Question: From the figure, is the trend upward or downward?
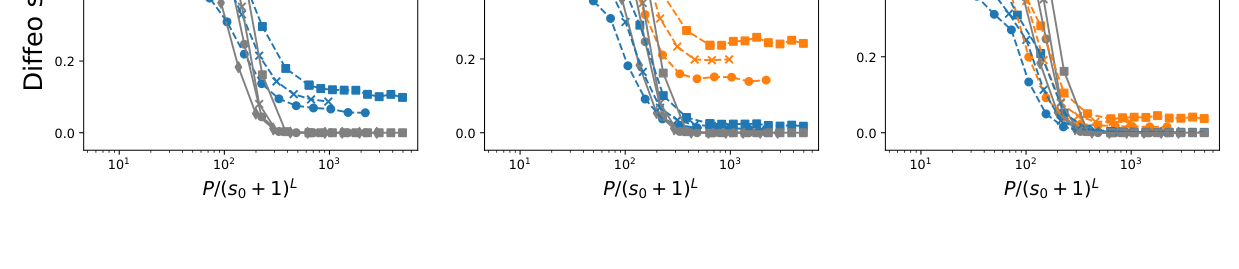
Answer: increasing